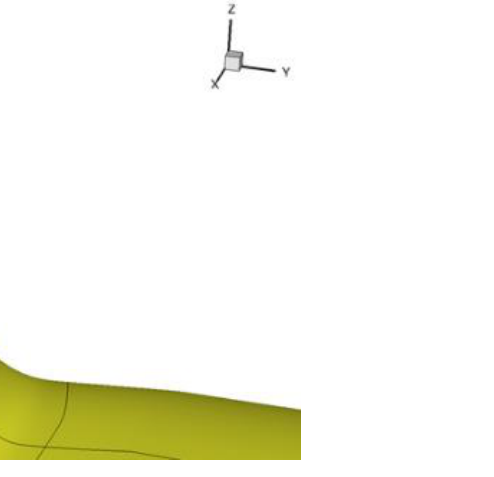
Figure 7 . Synchronous deployment of the upper and lower morphing tabs of the winglet, [34,37]. Figure taken with permission from authors.